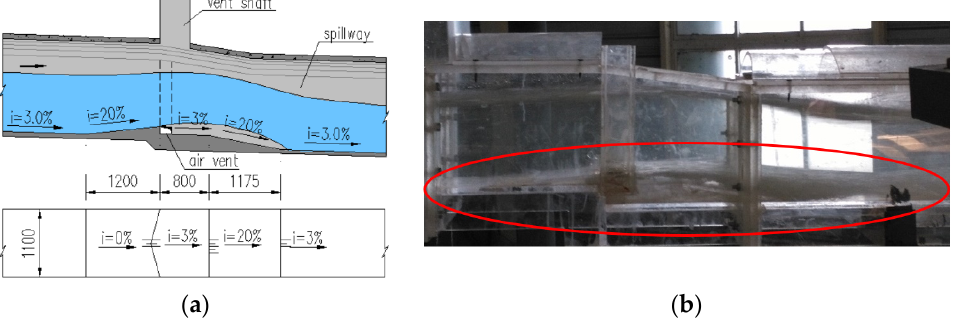
Figure 6. Shape design and flow pattern (Unit: cm): ( a ) the aerator shape suitable for a mild bottom slope; ( b ) flo w pattern of gentle bottom